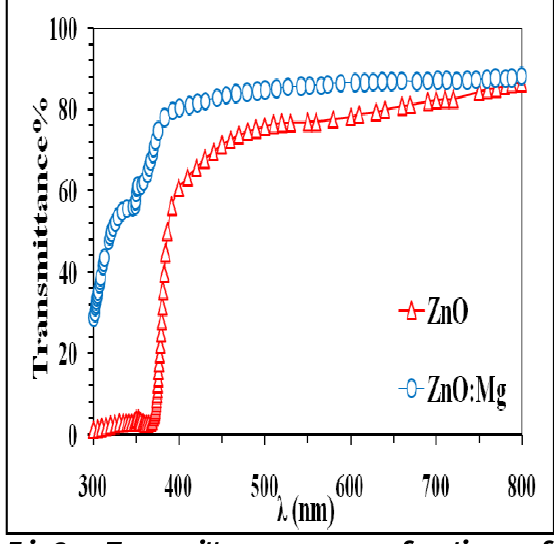
Fig.3: Transmittance as a function of wavelength for ZnO pure and doped thin films.